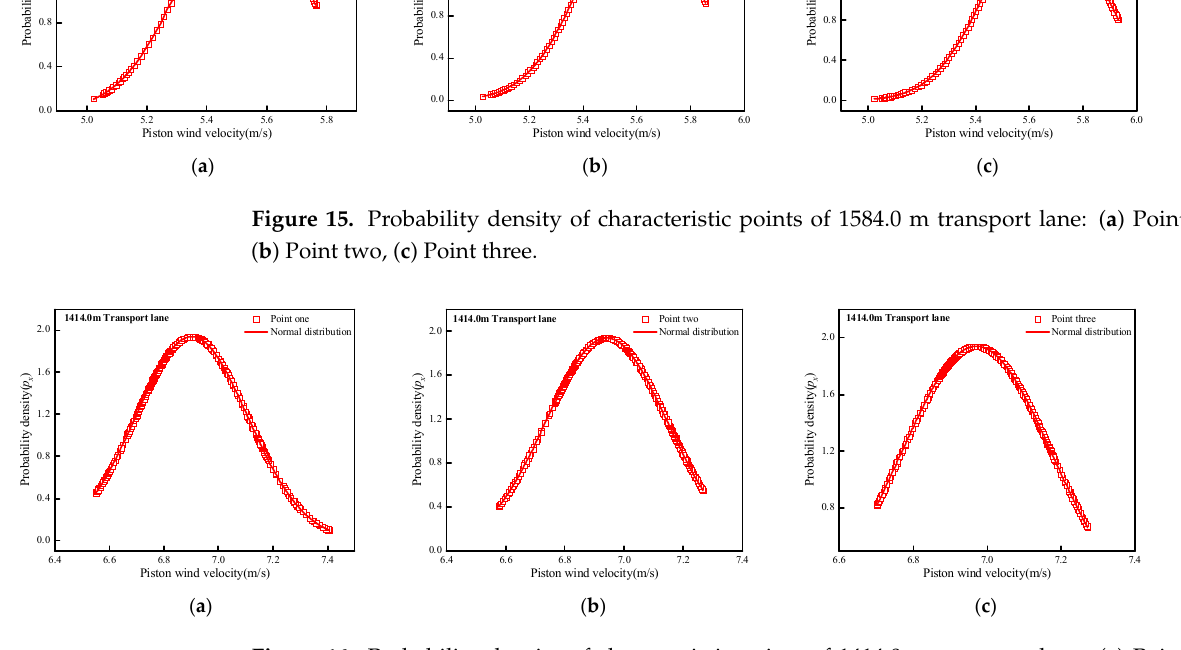
Figure 16. Probability density of characteristic points of 1414.0 m transport lane: ( a ) Point one, ( b ) Point two, ( c ) Point three.